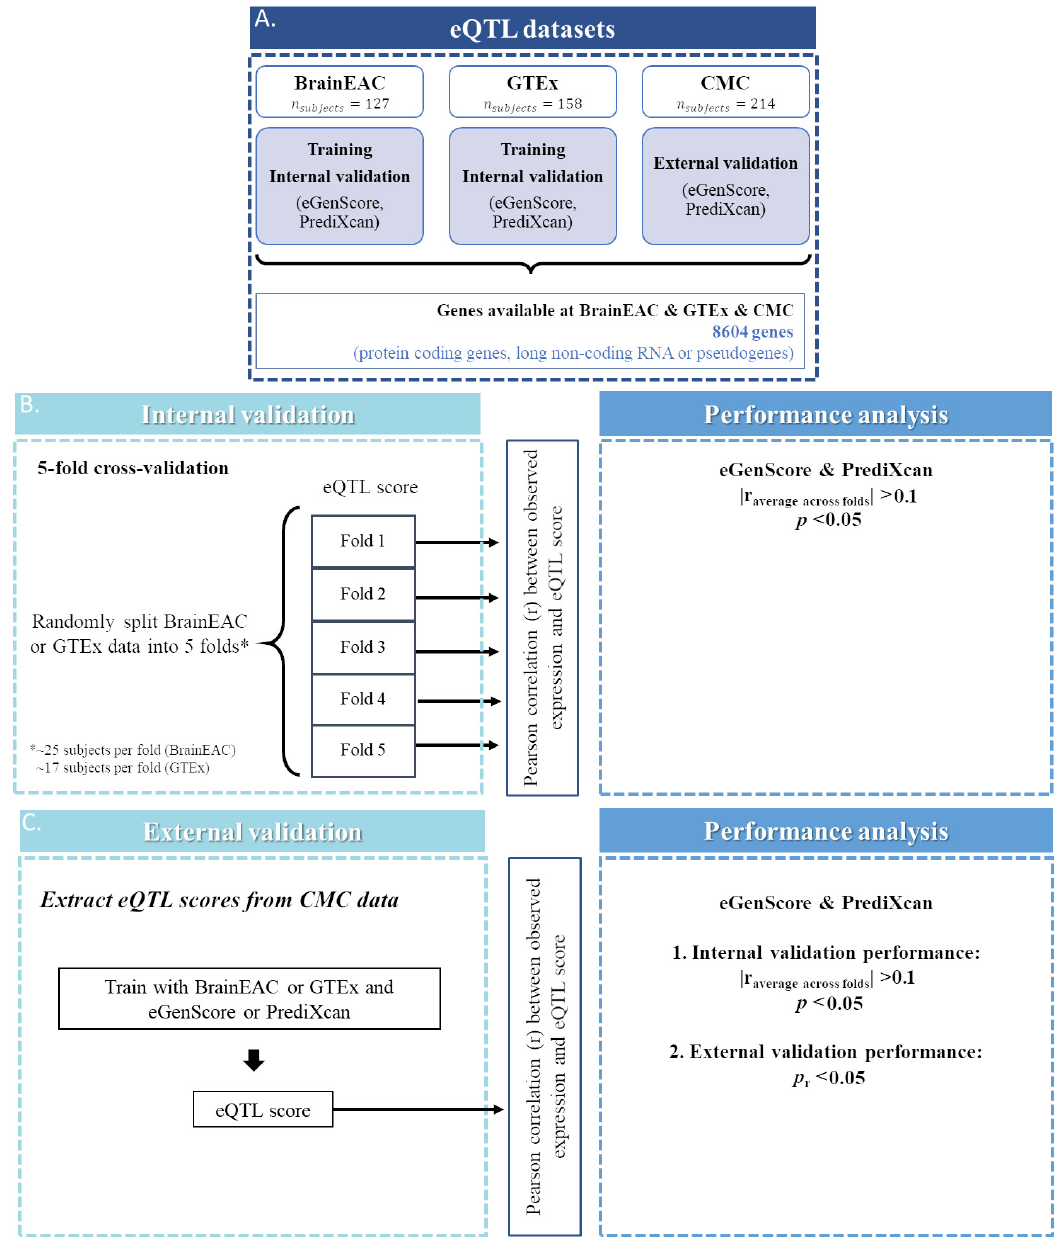
Figure 1. Representation of the steps taken for the selection of genes ( A ) for which an expression quantitative trait loci (eQTL) model was trained and validated, both internally ( B ) and externally ( C ). RNA: ribonucleic acid.